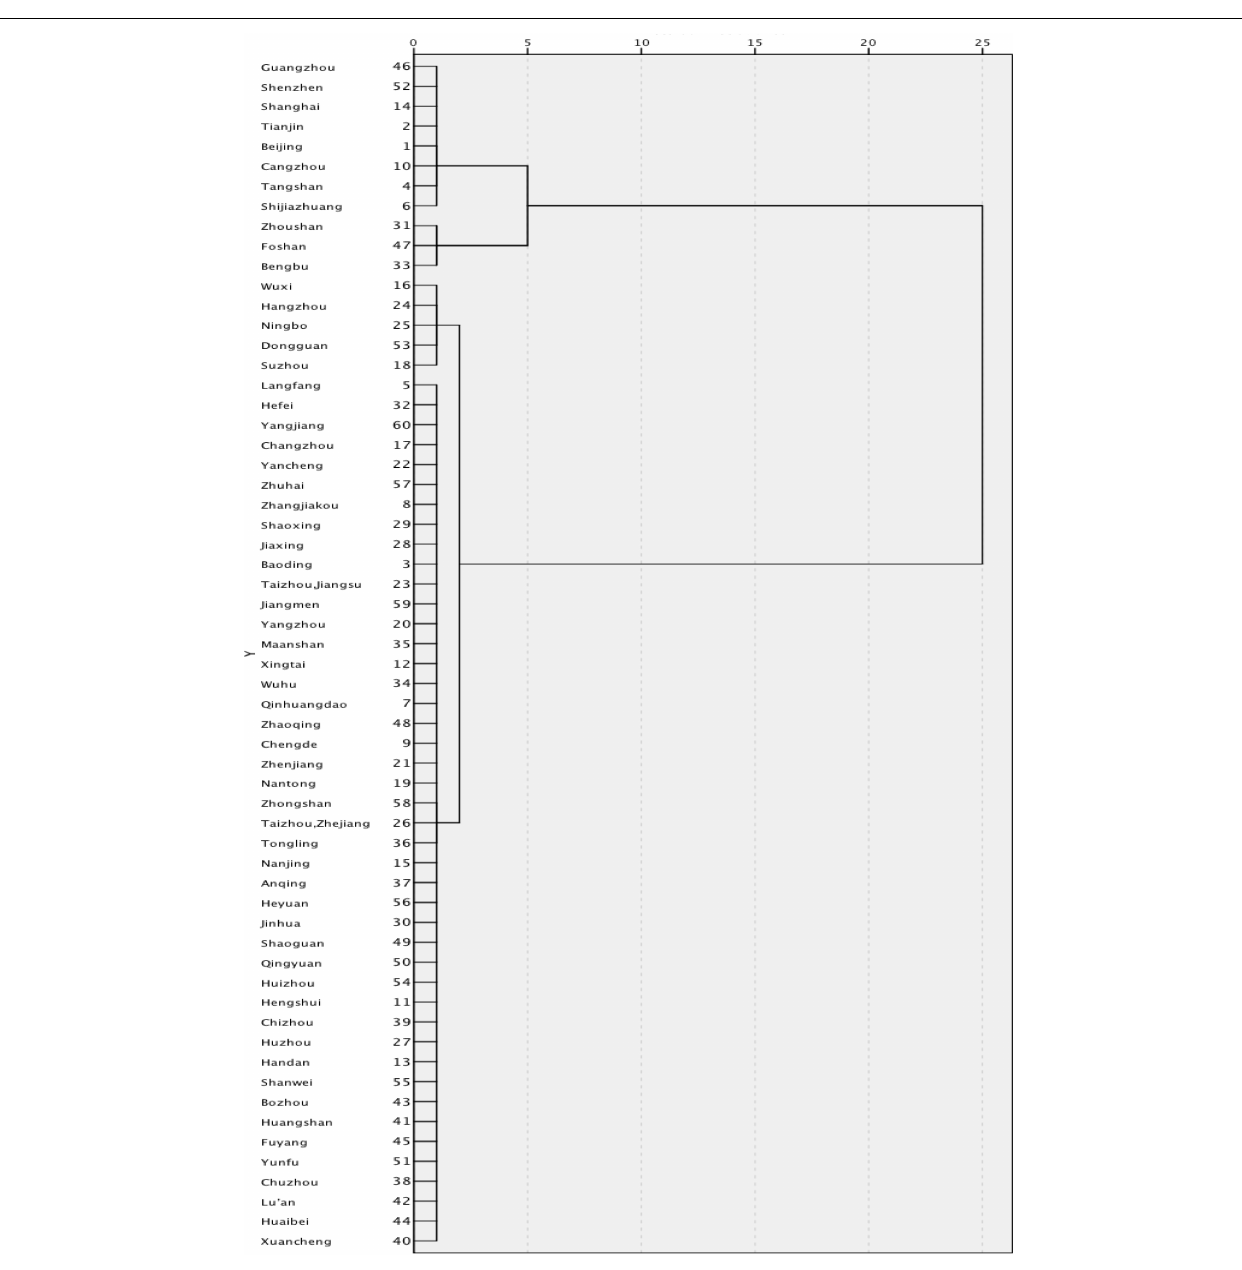
FIGURE 4 | Cluster analysis using average links (group spacing), re-scaled distance clustering